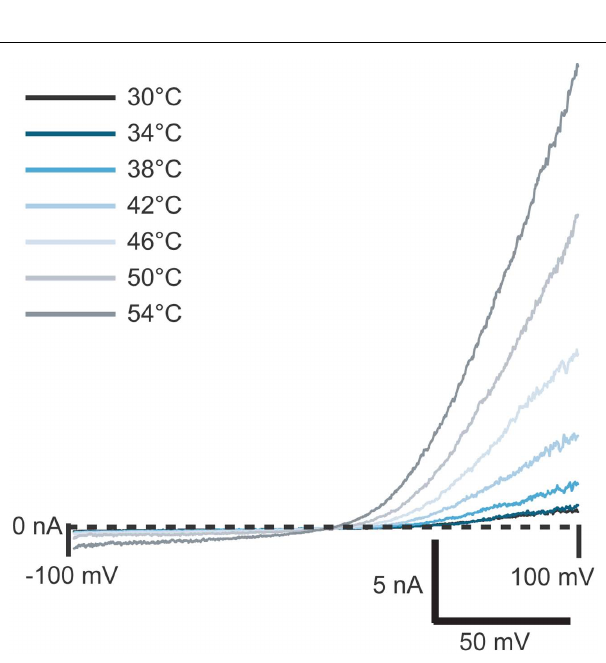
FIGURE 3 | (A) Currents elicited using a voltage ramp protocol from − 100 to 100mV over 200ms and activation ofTRPV3 receptors by increasing concentrations of 2-APB. (B) Concentration response curve for n = 11 cells revealing an EC 50 for 2-APB of 61.1 ± 7.6 μ M.